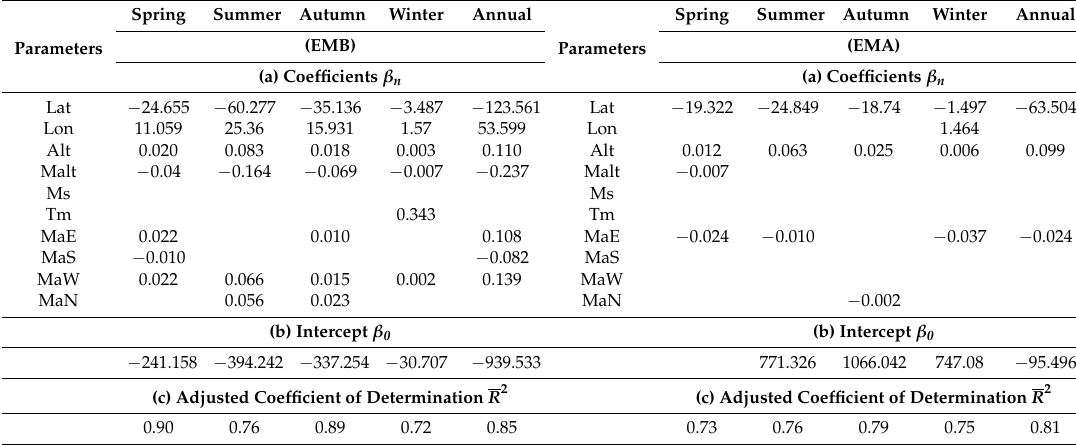
Table 6. Same as Table 5, but for areas with an elevation below 1700 m (EMB) and above 1700 m (EMA),